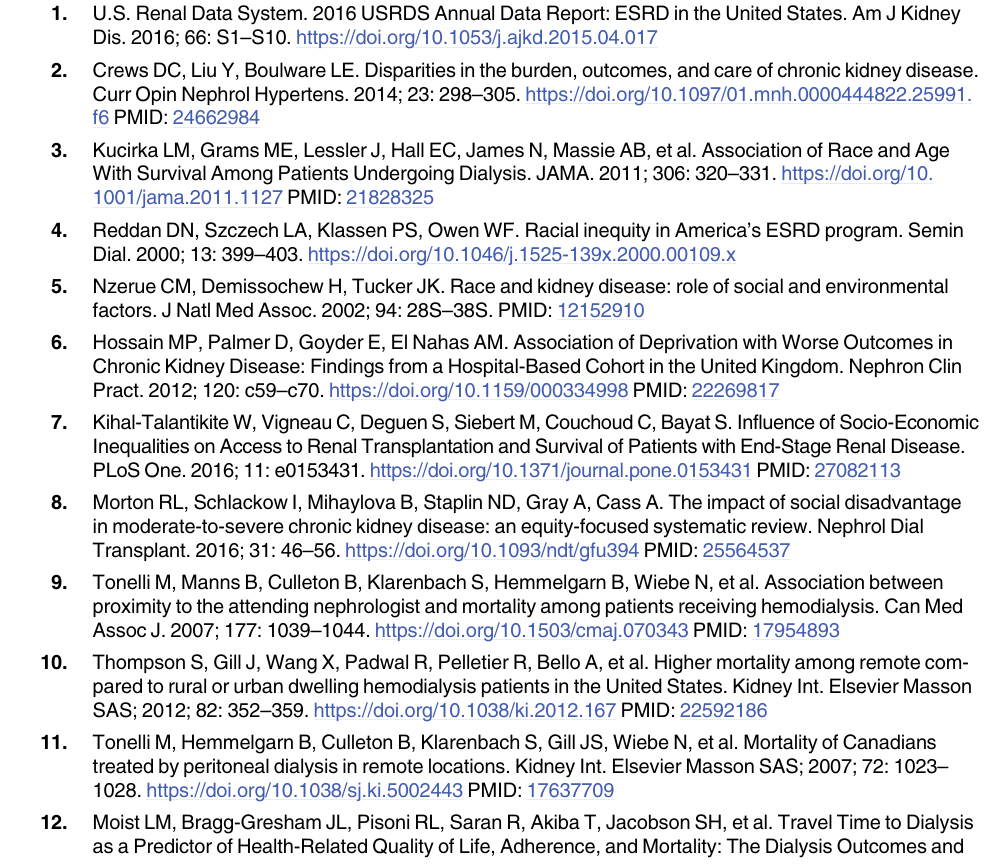
S1 Table. Hazard ratios for ESRD and total EQI stratified by age and distance to the near- est hospital (1,092,281 patients, 2000–2013). a HR (95% CI) = Hazard ratio (95% Confidence Interval). S2 Table. Hazard ratios for ESRD and total EQI stratified by rural versus urban location and distance to the nearest hospital (1,092,281 patients, 2000–2013). a HR (95% CI) = Haz- ard ratio (95% Confidence